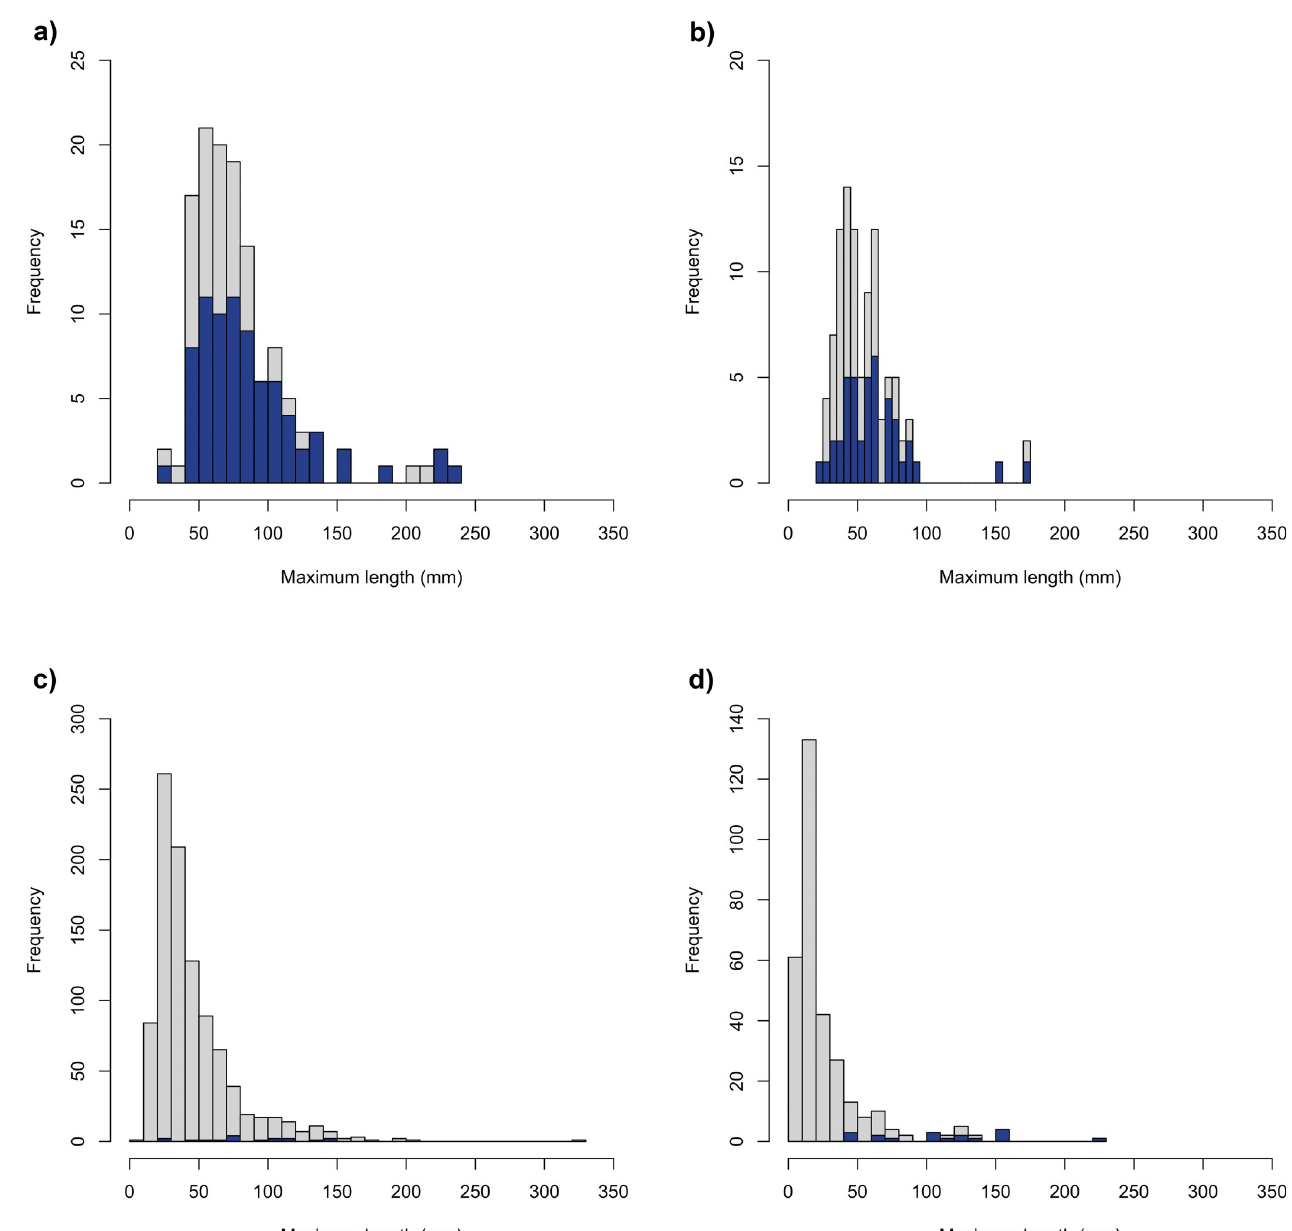
Fig 4. Frequencies of faunal fragments (in grey) and of specimens bearing flake scars (in blue) per maximum length (mm) size class. (a) PBT; (b) RCS; (c) CCS; (d) experimental Series 1 and Series 2